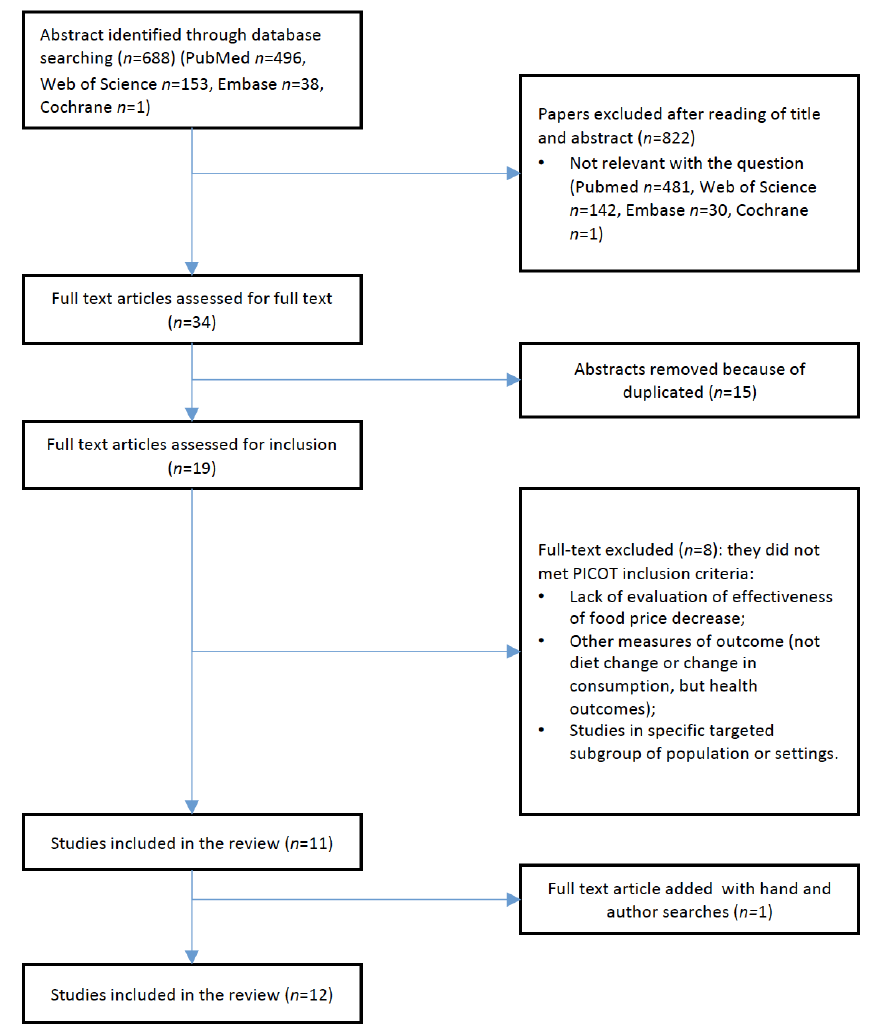
Figure 1. PRISMA (Preferred Reporting Items for Systematic Reviews and Meta-Analyses) flow diagram. Figure1.